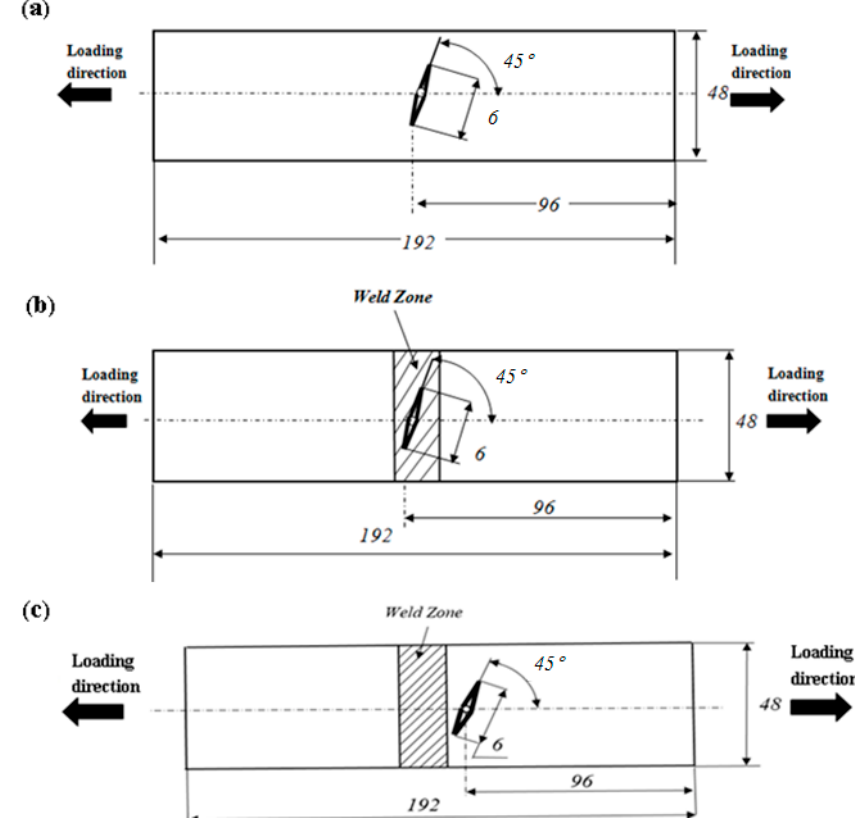
Figure 1. Three types of center-cracked fatigue specimen (mm): ( a ) the BM specimen; ( b ) the WM specimen; ( c ) the HAZ specimen. Table 1. Chemical component of the BM and filler (wt %).